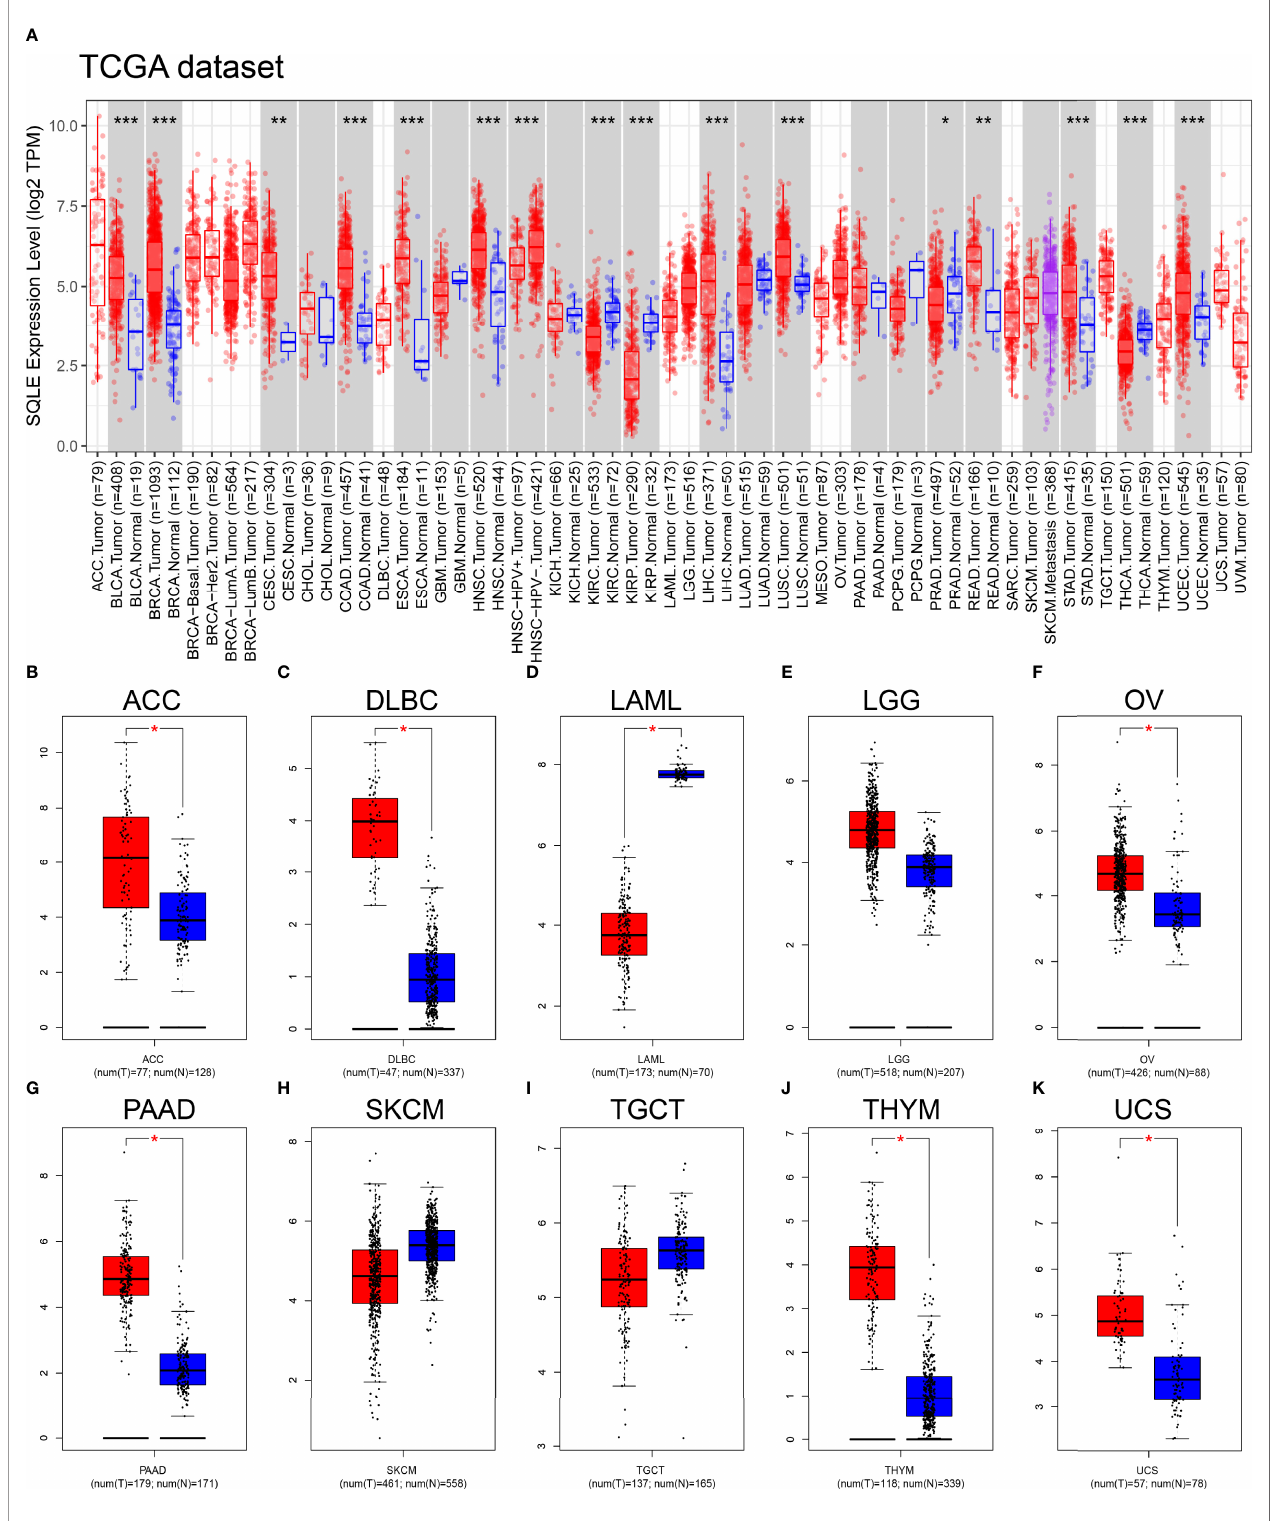
FIGURE 1 | SQLE expression level in human cancers. (A) SQLE expression in 33 types of human cancer based on TCGA dataset. (B – K) SQLE expression in ACC (B) , DLBC (C) , LAML (D) , LGG (E) , OV (F) , PAAD (G) , SKCM (H) , TGCT (I) , THYM (J) , and UCS (K) compared with corresponding TCGA and GTEx normal tissues. *p < 0.05; **p < 0.01; ***p <